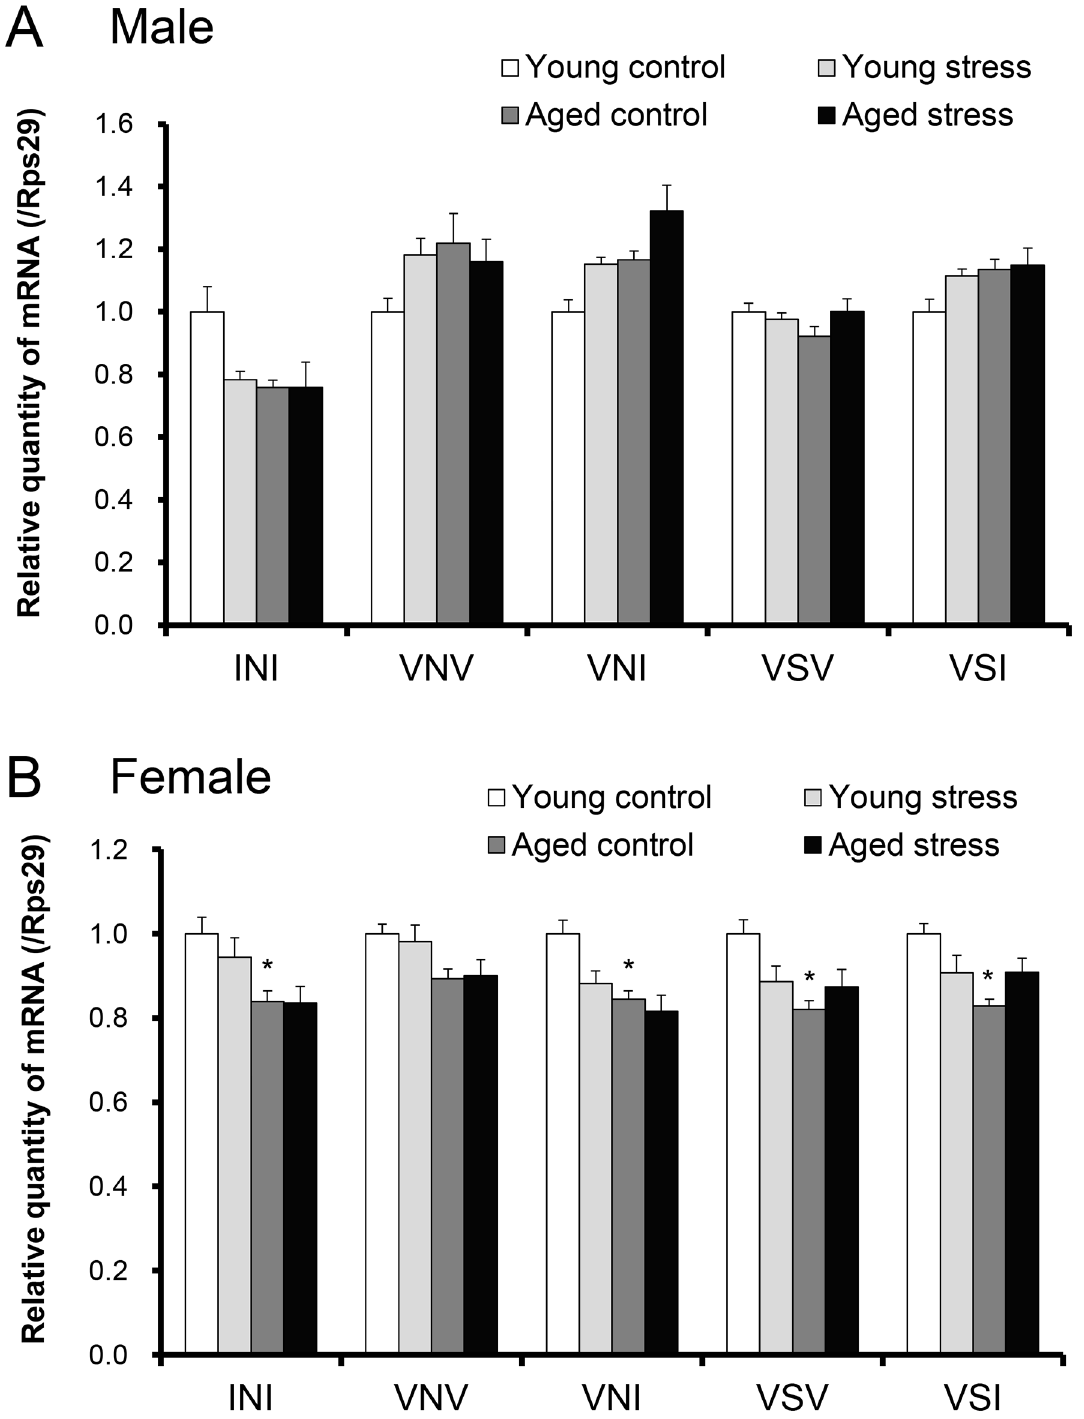
Fig 5. Changes in hypothalamic 5-HT 2C R pre-RNAediting in aged male or female mice exposed to novelty stress. (A) Male mice, (B) Female mice. The hypothalami were harvested6 h after stress exposurein 18 h-fasted mice. Data are presentedas the mean ± SEM (youngand aged stressed group; n = 8, aged male control group; n = 5, aged female control group; n = 7). * , p < 0.05 vs. youngcontrol group.